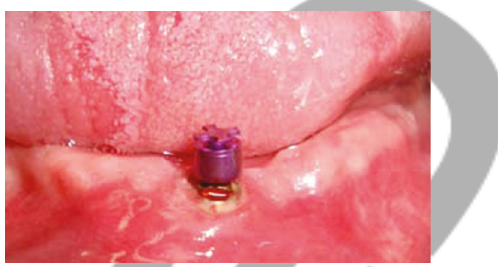
Figure 2: Retentive anchor screwed into the implant 3 weeks after implant placement.